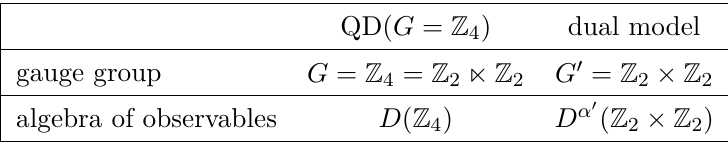
Table 1 . PEM duality in the QD model with G = Z 4